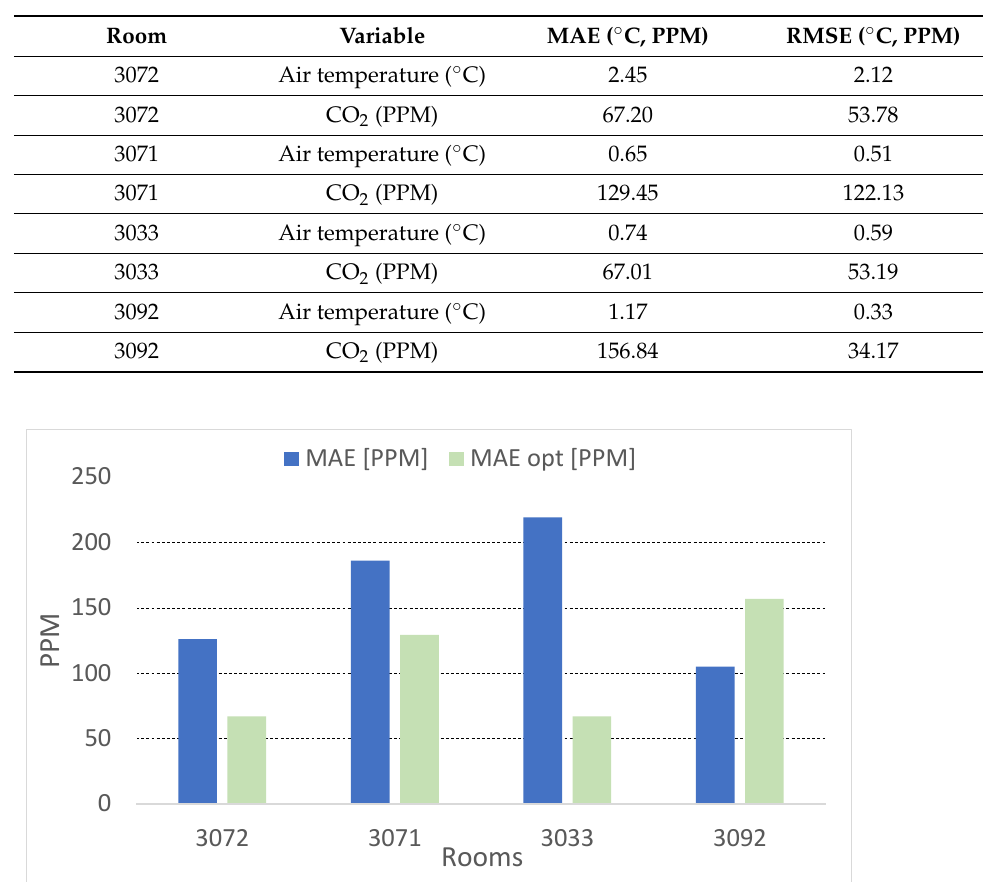
Figure 11. Mean absolute error for the CO 2 concentration: comparison calibrated model vs. optimized model.